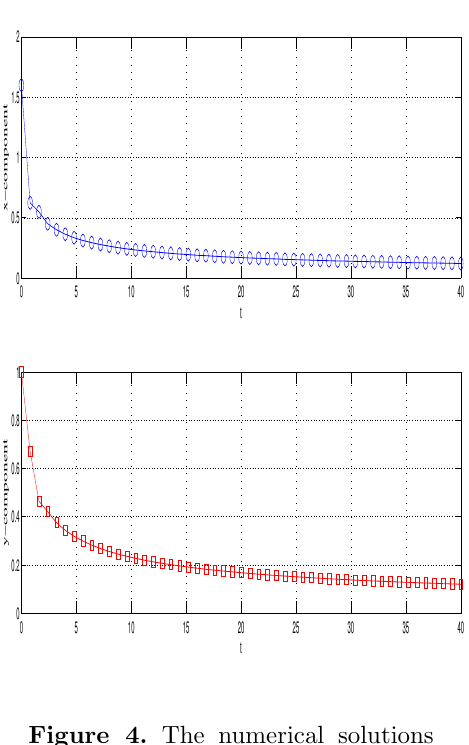
Figure 2. The numerical solutions obtained by the RK2 scheme with h = 0 . 63 after 50 iterations in Exam- ple 3.